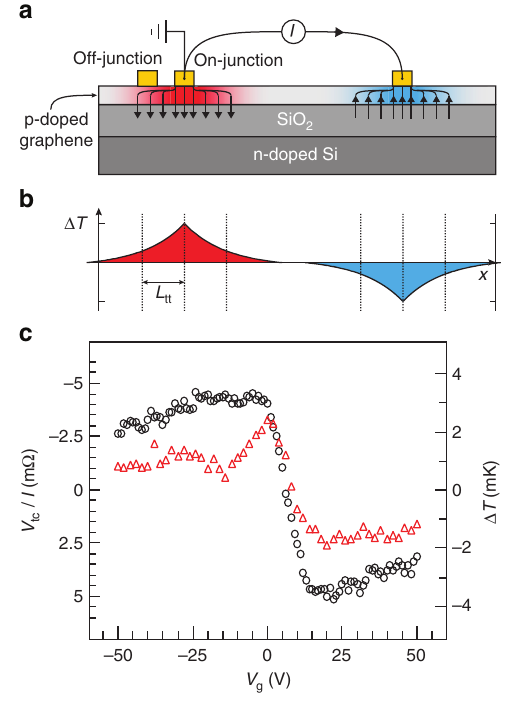
Figure 5 | Temperature profile and off-junction